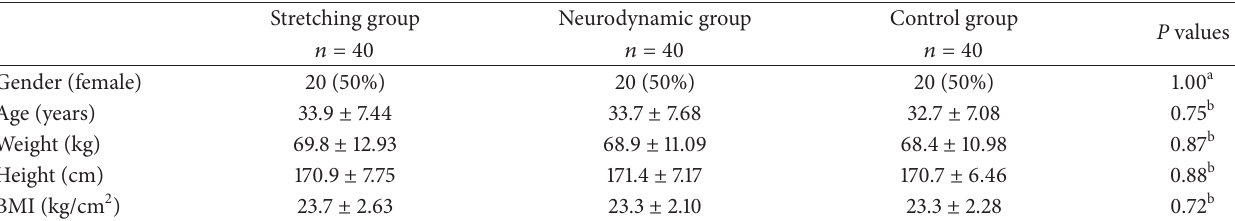
Figure 4: Neurodynamic sciatic slider technique was performed by alternating hip flexion, knee flexion, and ankle dorsiflexion with hip extension, knee extension, and ankle plantarflexion while the subject’s cervical and thoracic spine were maintained in flexion. Movements were performed for 180 seconds on their dominant leg. Table 1: Baseline sample characteristics.